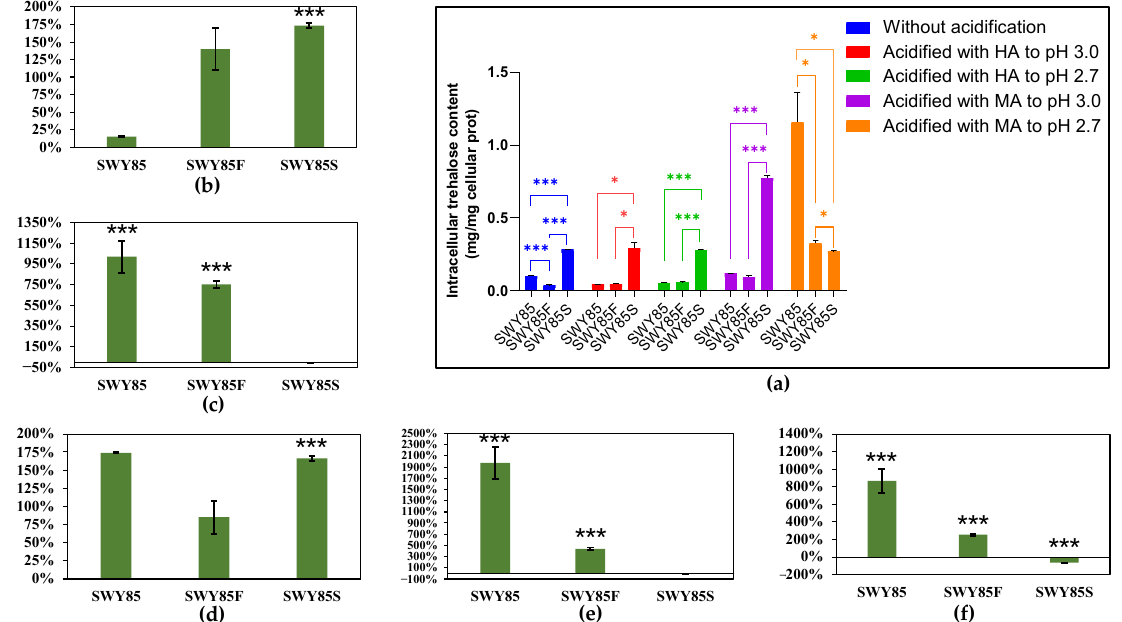
Figure 4. The intracellular trehalose accumulations of the three strains in YPD medium ( a ), and the variations of intracellular trehalose content in the cultivations of strains cultured with adequate nutrients between different culture conditions (from non-acidification to the acid stress of pH 3.0 ( b ) and to the stress of pH 2.7 ( c ) acidified with malic acid, from the acid stress acidified with hydrochloric acid to the acid stress acidified with malic acid at pH 3.0 ( d ) and at pH 2.7 ( e ), and from the acid stress of pH 3.0 acidified with malic acid to the strengthened malic acid stress of pH 2.7 ( f ), respectively.) HA, Hydrochloric acid; MA, Malic acid. * p < 0.05, *** p < 0.001.